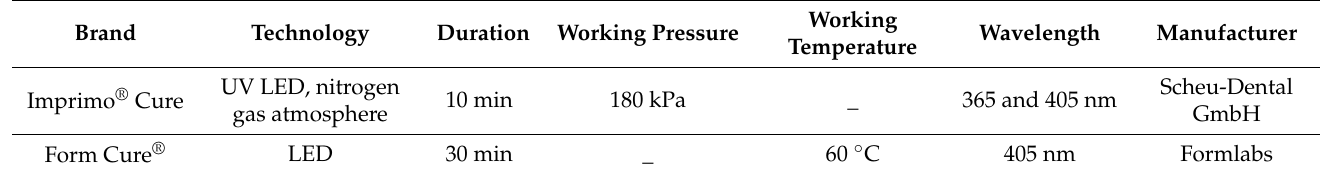
Table 2. Characteristics of investigated post-curing